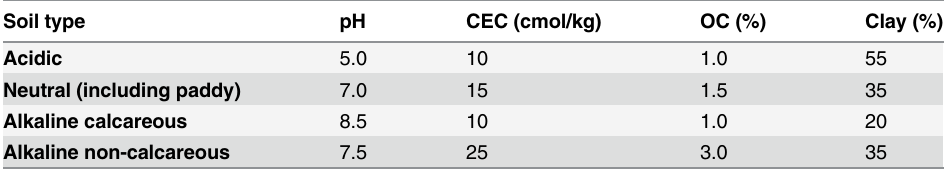
Table 2. Four representative scenarios of Chinese